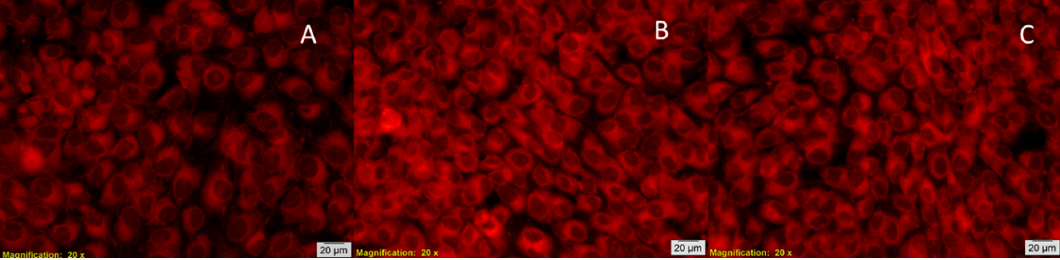
Figure 9. Fluorescence microscopy images of the human AFSC monolayer in the presence of ( A ) PLA NPs; ( B ) PLA/5-LG NCs and ( C ) control. The cells present a normal morphology, are adherent, and have a relative uniform distribution after five days of PLA/5-LG NC stimulation.